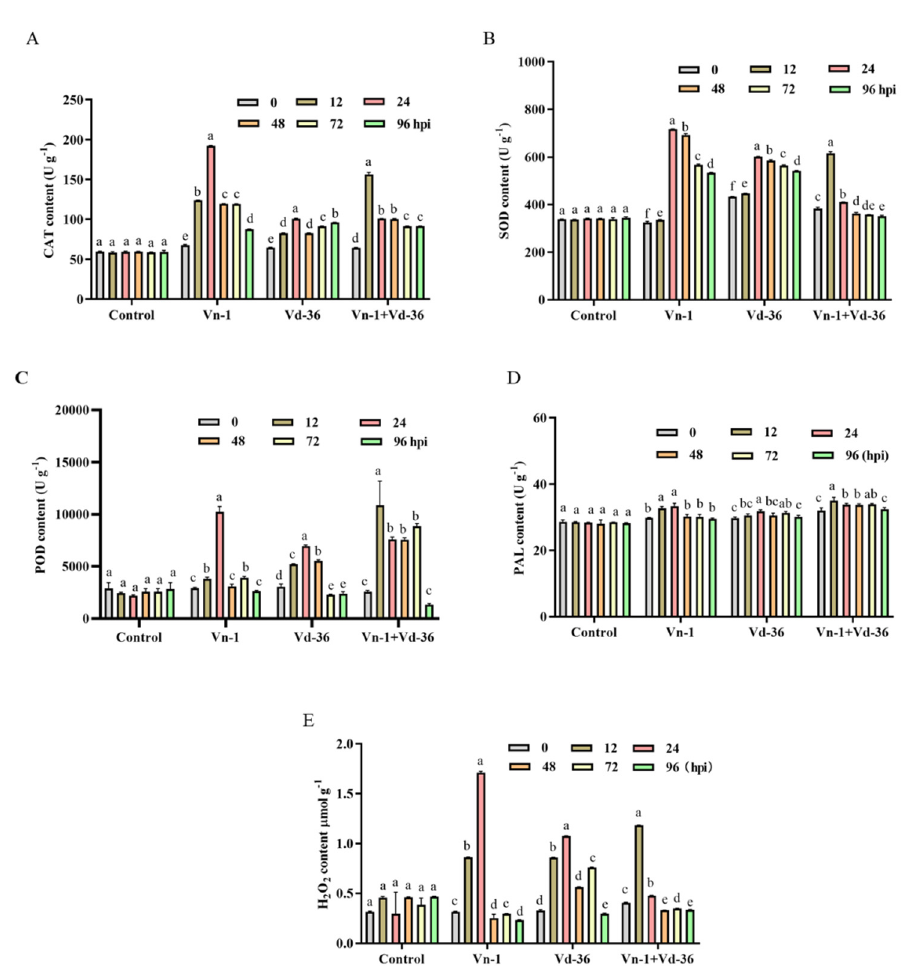
Figure 2. Reactive oxygen species (ROS) burst in different treatments as assessed by 3,3’ ‐ diamino ‐ benzidine (DAB) staining: ( A ) potatoes inoculated with Vn ‐ 1, followed by Vd ‐ 36 inoculation after 5 d; ( B , C ) potatoes inoculated with Vn ‐ 1 and Vd ‐ 36 alone, respectively; ( D ) sterile water was used to inoculate the controls.